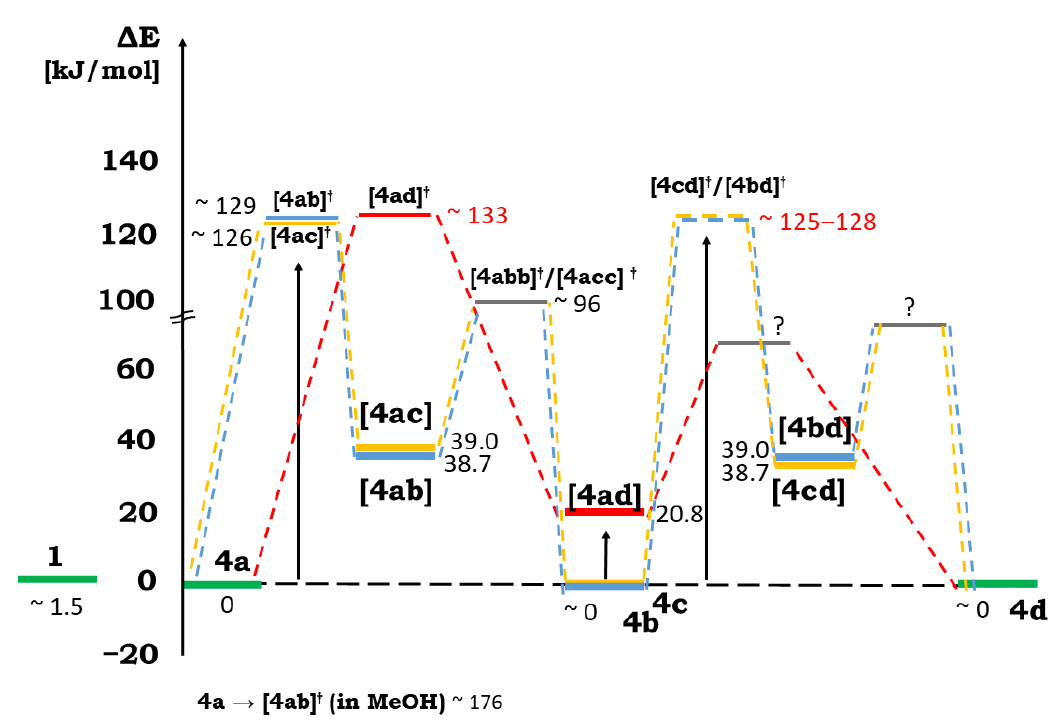
Figure 8. Energy profile visualization of the putative intermediates and transition states involved in catechin/D 2 O deuteration process 1 → 4a → 4d .